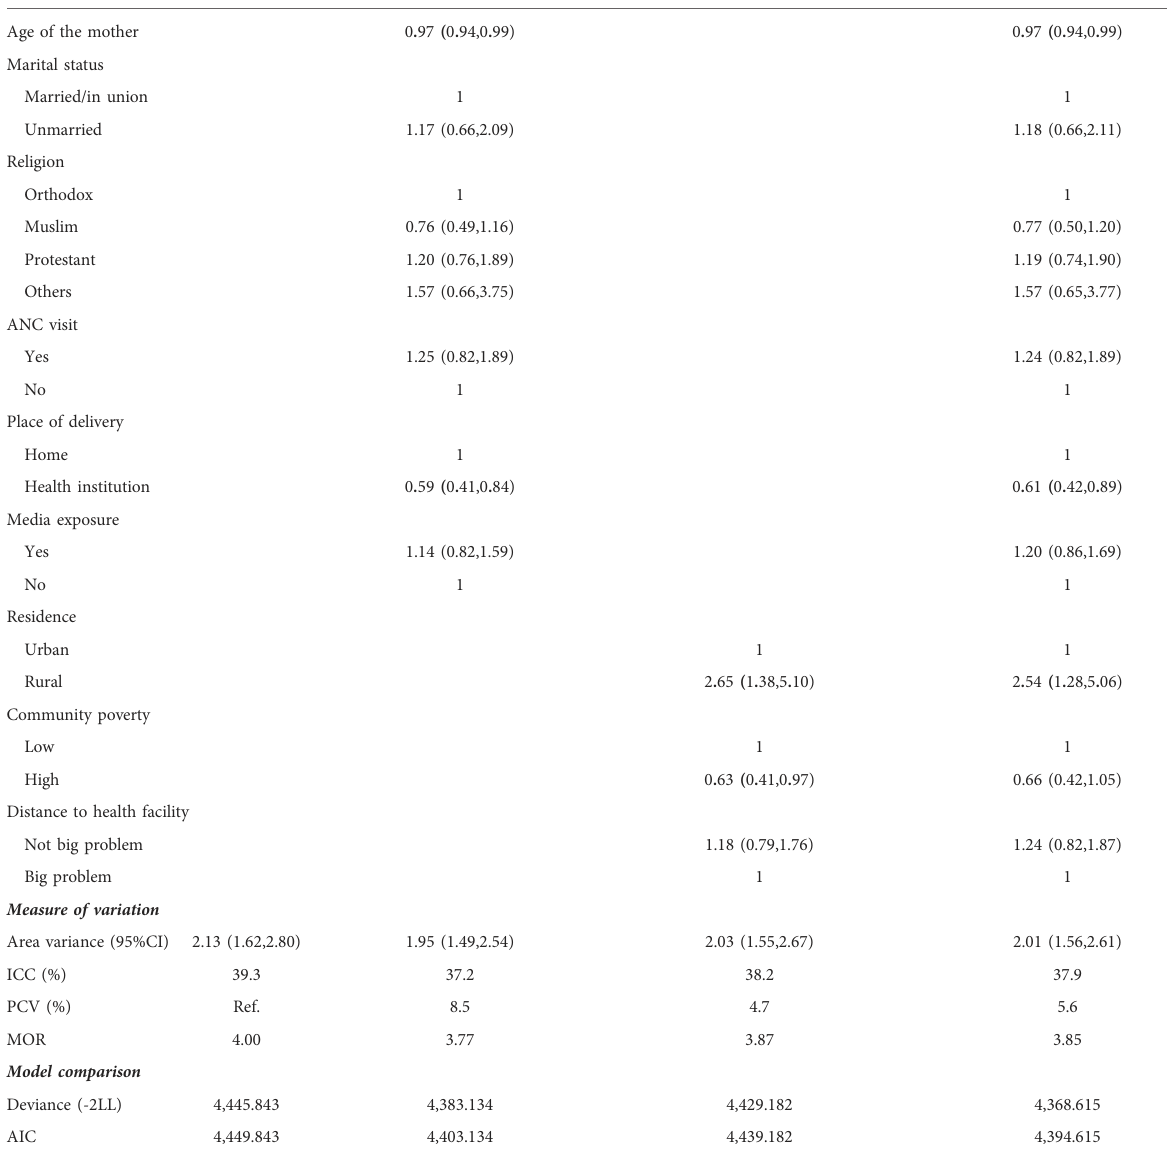
TABLE 4 Multilevel binary logistic regression analysis for factors associated with umbilical cord stump application of cow dung and/or oil in Ethiopia, EDHS 2016.